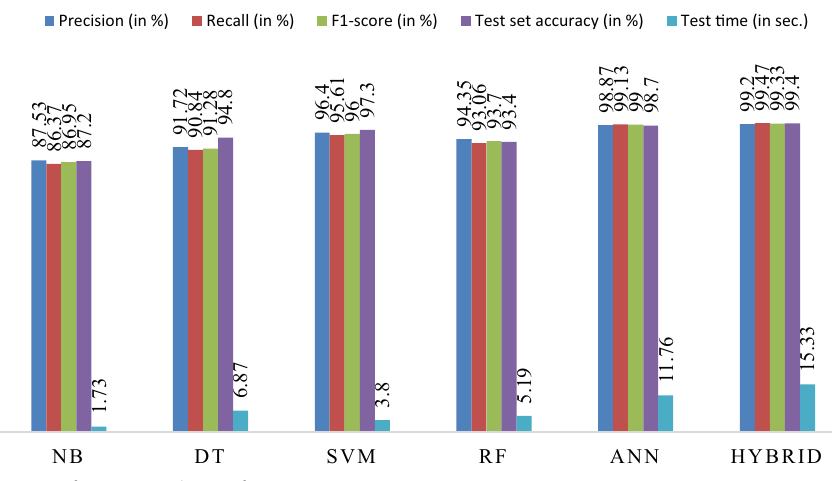
Fig. 6 Performance evaluation for test